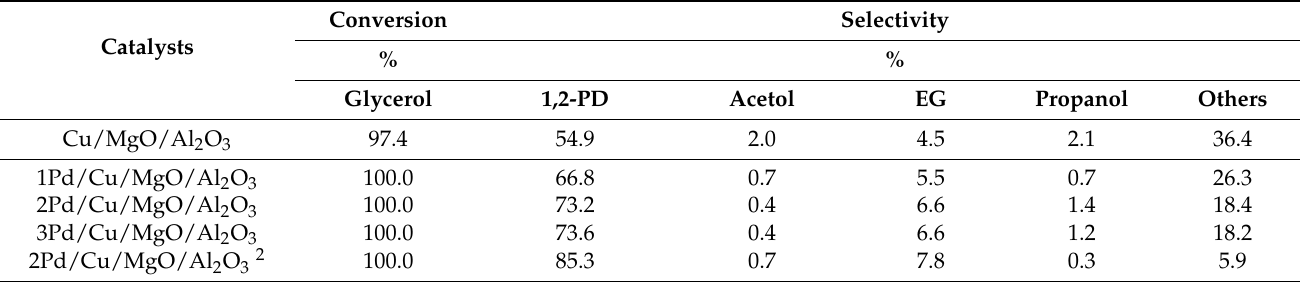
Table 4. Effect of Pd loading on the conversion of glycerol and selectivities of products 1 .